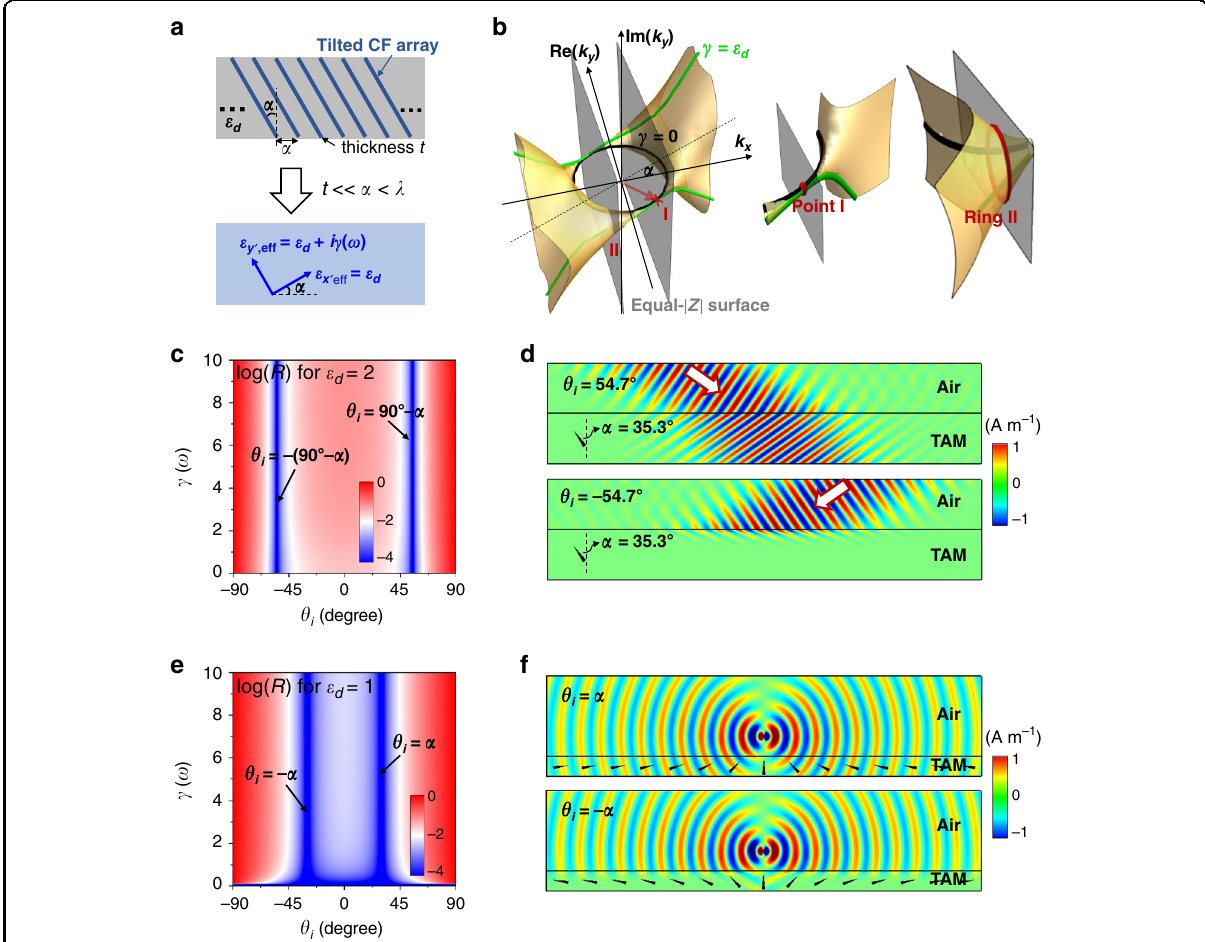
Fig. 2 Ultra-broadband Brewster effect with controllable absorption by using tilted CF arrays. a Illustrations of a tilted CF array embedded in a dielectric of ε d (upper) as the effective TAM (lower). b The equal-frequency surface of the effective TAM that is formed by varying γ ω ð Þ . The black and green lines denote the EFCs regarding the cases of γ ω ð Þ ¼ 0 and γ ω ð Þ ¼ ε d , respectively. The gray surfaces denote the equal- Z j j surfaces, which intersect with the equal-frequency surface at point I and the ring II (enlarge insets in the right). Calculated re fl ectance as functions of the θ i and γ ω ð Þ for TM-polarized waves incident onto the effective TAM with c ε d ¼ 2 and α ¼ 35 : 3 (cid:2) , or e ε d ¼ 1 and α ¼ 30 (cid:2) , respectively. d Simulated magnetic- fi eld distributions when a TM-polarized Gaussian beam is incident onto the effective TAM with ε (upper) or θ i ¼ (cid:3) 54 : 7 (cid:2) (lower). f Simulated magnetic- fi eld distributions for a TM-polarized dipole source above an inhomogeneous TAM with fi xed ¼ 1 and γ ω ð Þ ¼ 3 but varied α . The α is adjusted along the surface so that the condition of θ ε d everywhere. The arrows in ( d , f ) denote the orientation of the axis ε y ′